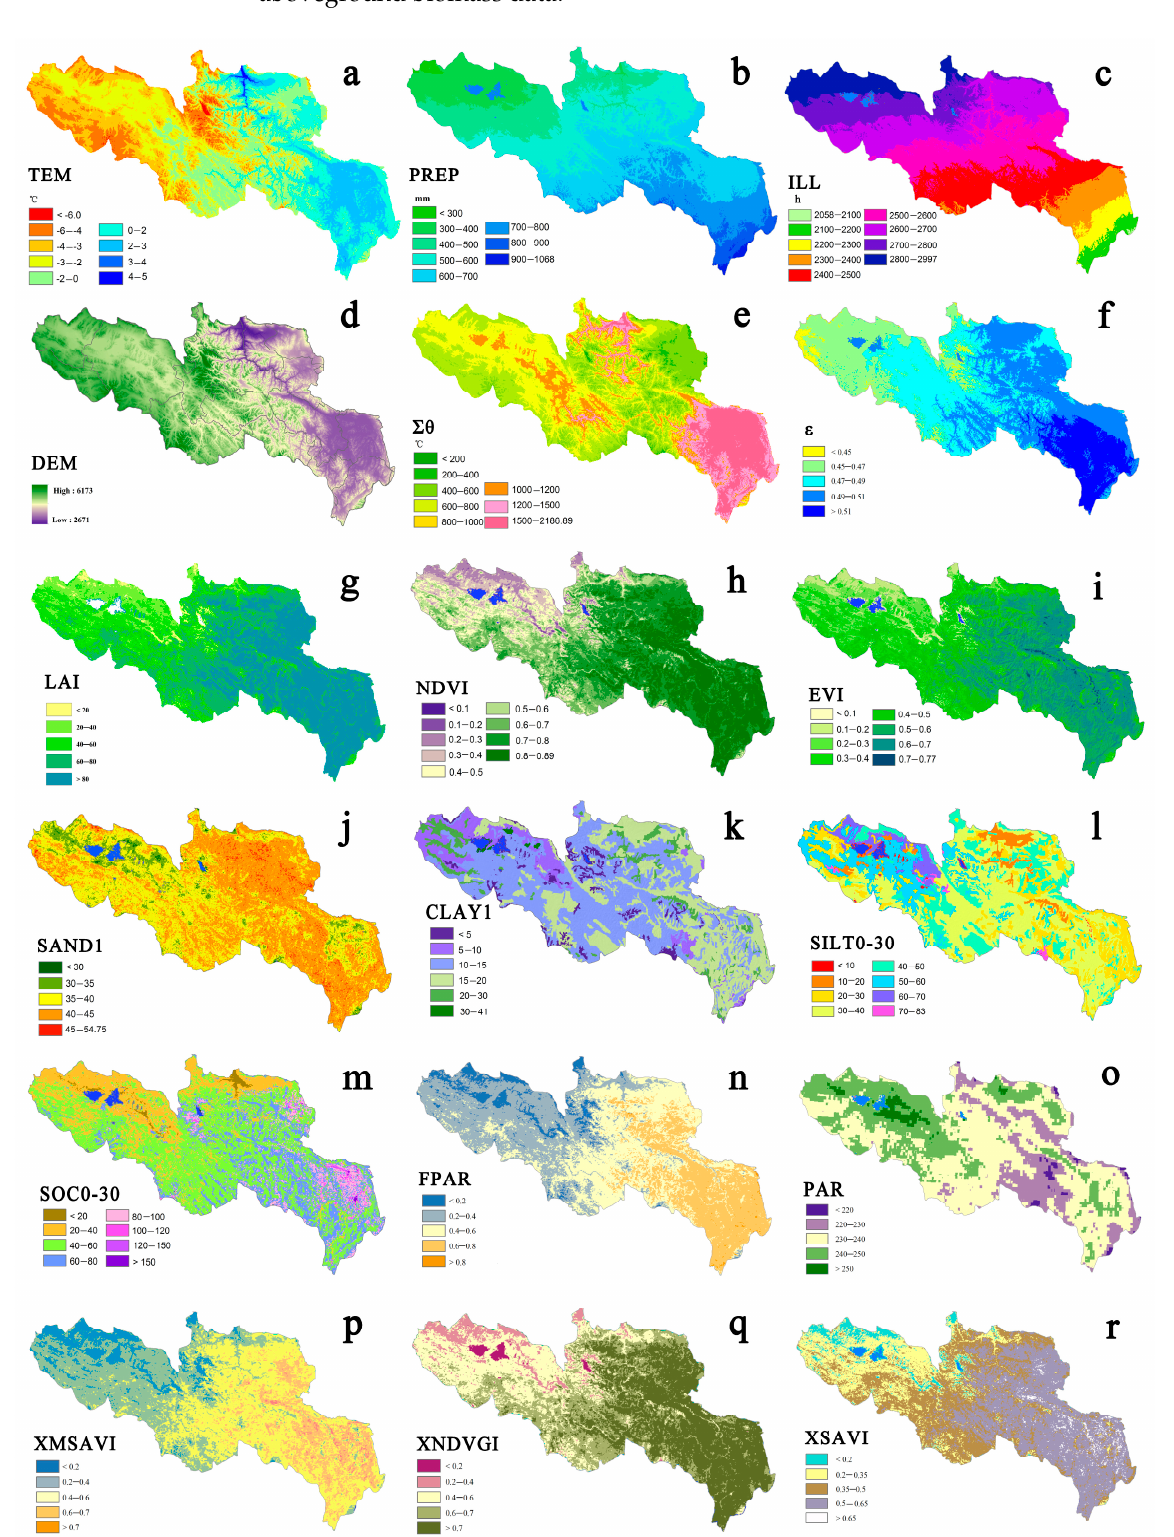
Figure 2. Spatial distribution of main environmental variables (The information of Figure ( a )–( r ) is shown in Table 1).